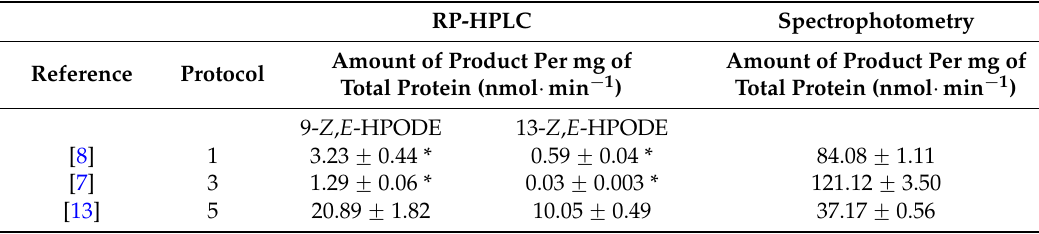
Table 3. LOX specific activity determined by RP-HPLC and spectrophotometrically at 27 ˝ C.